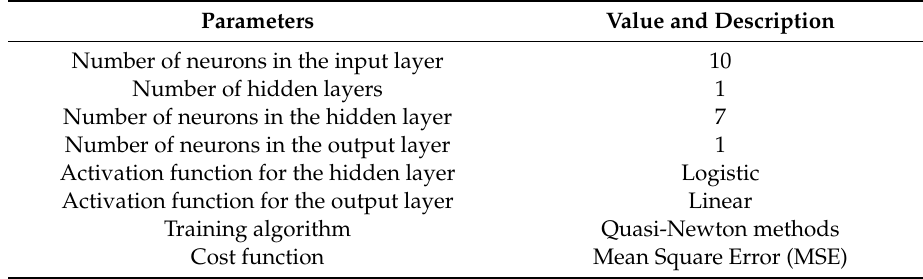
Table 3. ANN parameters used in this study